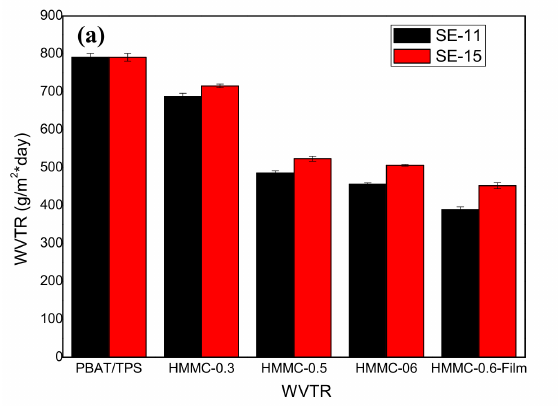
Figure 5. The WVTR ( a ) and OTR ( b ) of PBAT-HMMC composites (SE-11 and SE-15